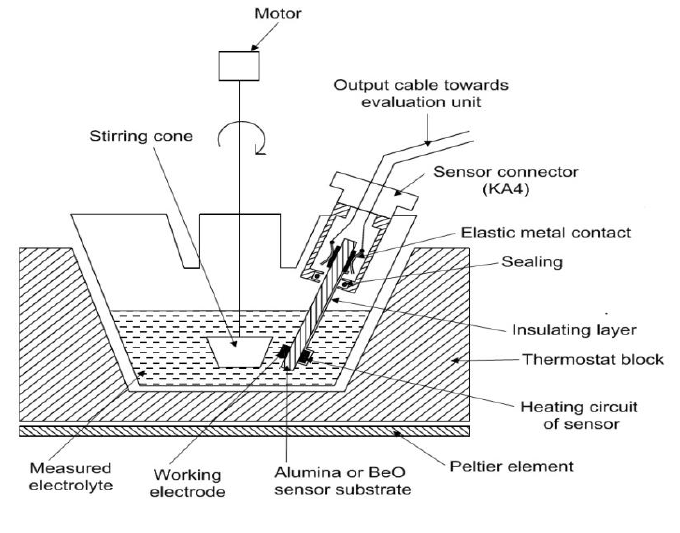
Figure 3. The time dependence of sensor output current; comparison of Cottrell response (■ T = T ) and response with thermo diffusion (▲ T 1 2